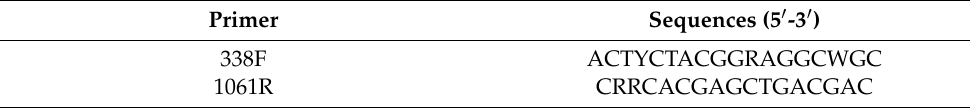
Table 3. Primer set used for 16S rRNA gene